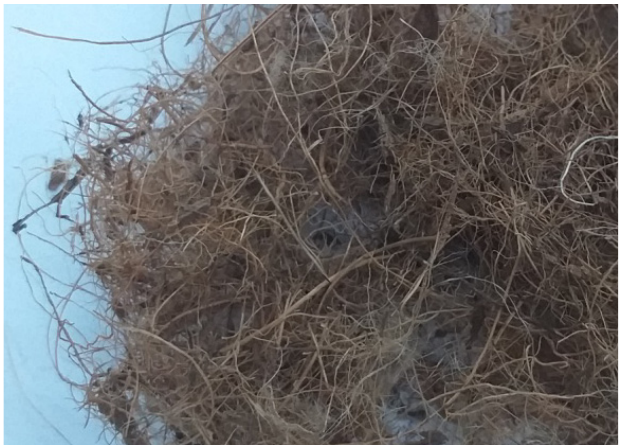
Figure 5. The fibres of coconuts.